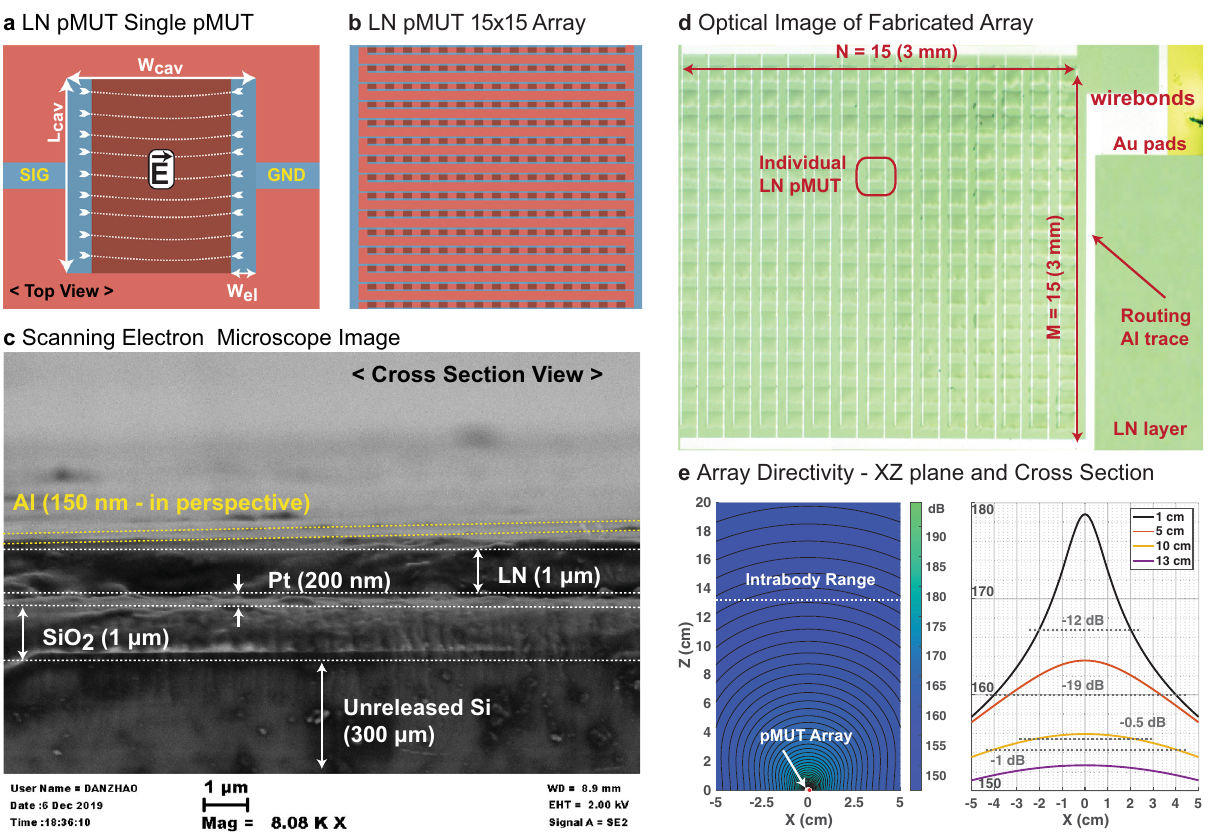
Fig. 1 Lithium Niobate (LN) pMUTs. a Design of a single element LN pMUT- dimensions of its cavity, electrodes, and bonding pads. b Design of a 15×15 LN pMUT array. c Cross section of LN pMUT with Scanning Electron Microscope (SEM). We can distinguish top electrode (Al), piezoelectric layer (LN), un- patterned bottom electrode (Pt), structural layer (SiO 2 ), and the unreleased substrate (Si). d Optical image of the fabricated 15×15 LN pMUT array. This